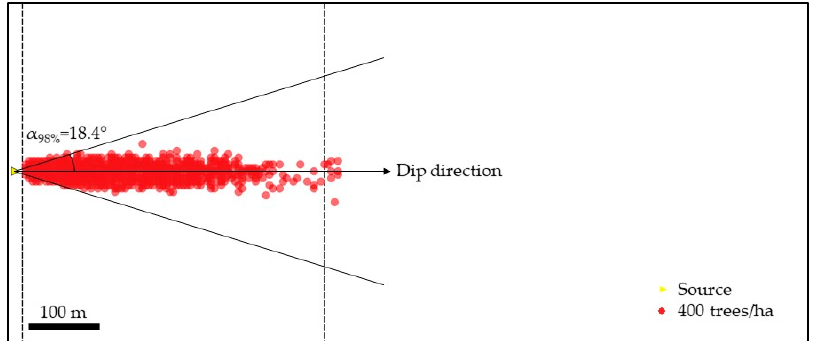
Figure 12. Overestimated runout zone assuming α 98% for the cone in the case a significant number of blocks stops just below the source. Reference is made to the scenario described in Figure 7a.